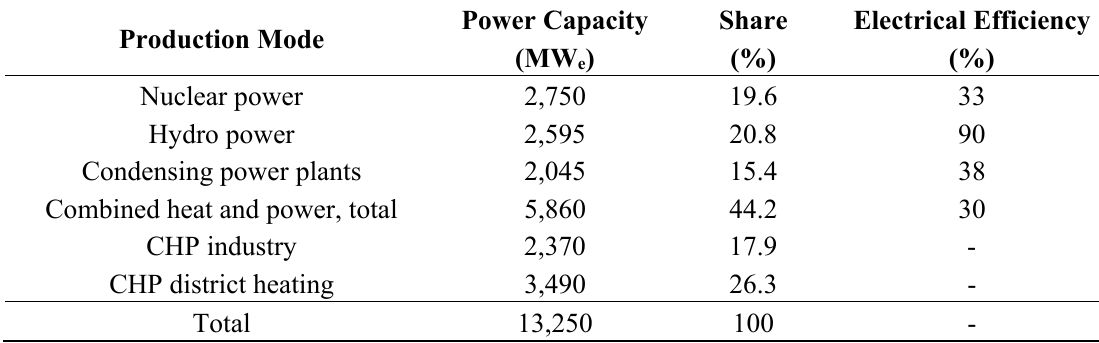
Table 1. Power generation capacity at peak load in Finland 2012 (data from